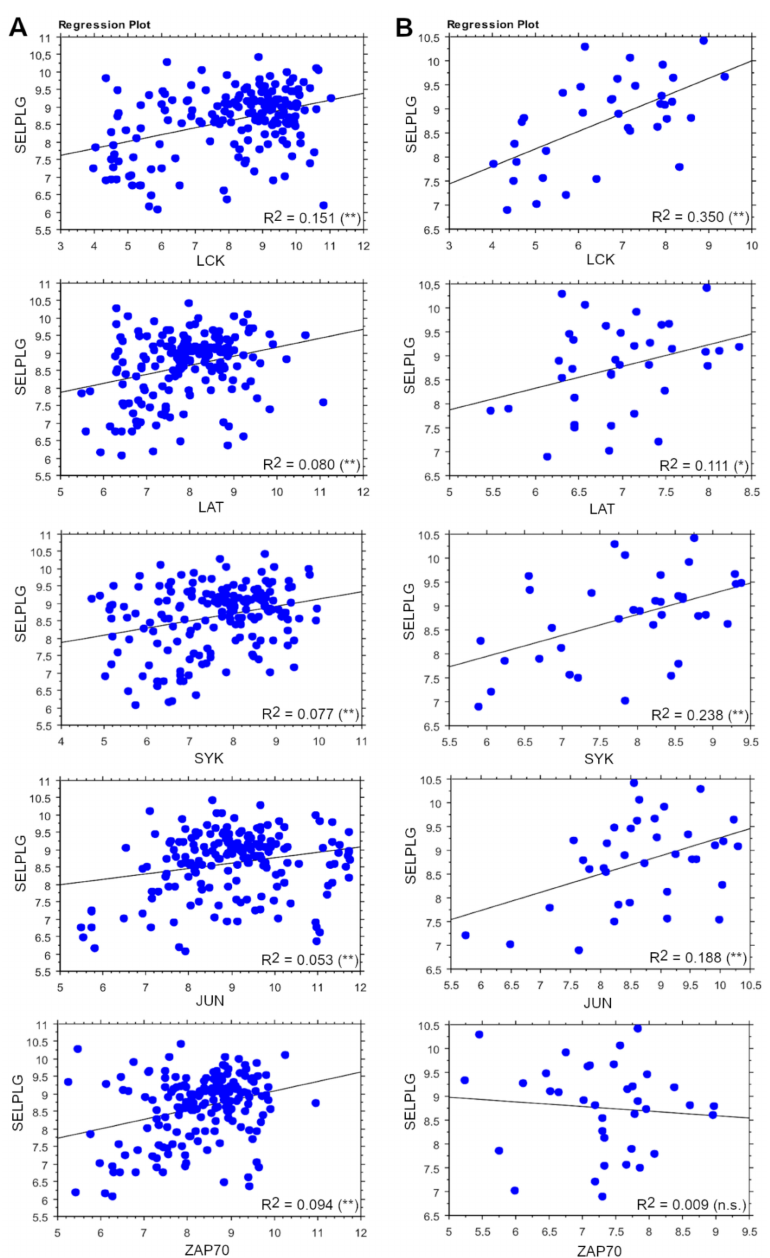
Figure 4. The correlation of the expression of SELPLG and TCR effector genes. The expression of LCK, LAT, SYK, JUN and ZAP70 genes in correlation with that of SELPLG in the whole T-cell setting ( A ) and in ALCLs only ( B ). p -values: n.s. = not significant; * = < 0.05; ** = <